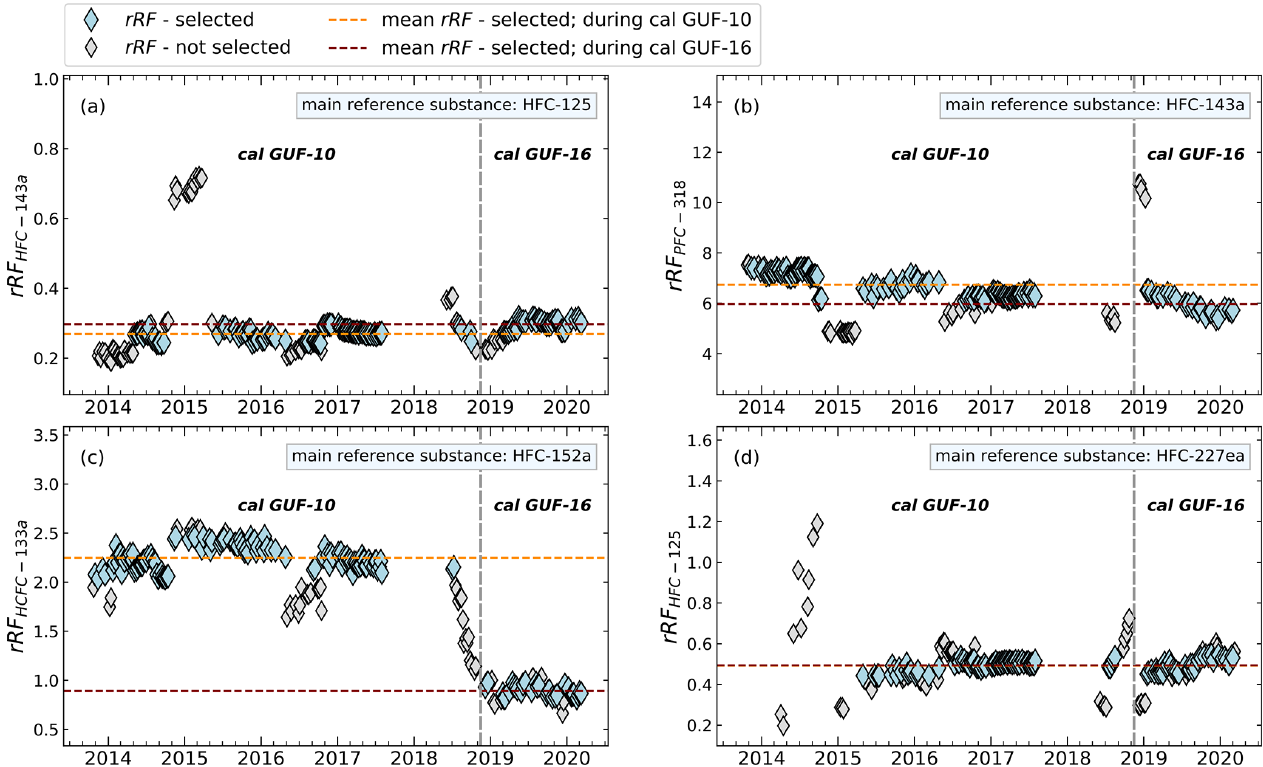
Figure 4. Differences of calculated and filtered rRF of whole-air flask sample measurements during the use of the GUF-10 and GUF-16 calibration standards. As exemplary compounds, different main reference and evaluation substances (rRF evalu ) are shown. The vertical grey dashed line indicates the change of the used calibration